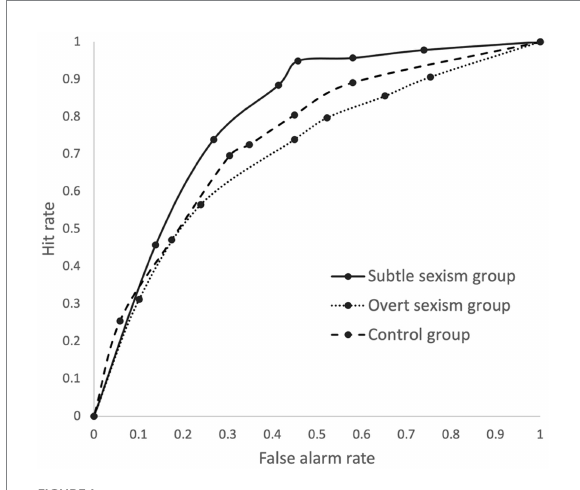
FIGURE 1 Pooled average ROC curves of the experimental